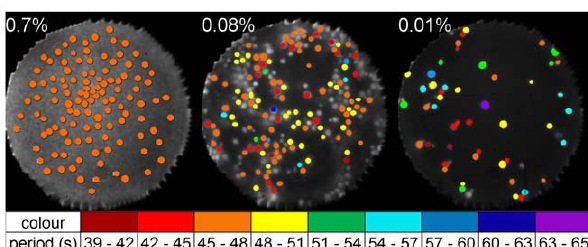
Figure 5. Mapping of the oscillation periods of individual cells in a population, for three experiments at cell densities of 0.7%, 0.08% and 0.01%, respectively. While for high cell densities (e.g. r =0.7%; not all cells labelled) all cells show same the oscillation period, the cells lose coherence in oscillation periods at lower cell densities ( r =0.08% and 0.01%). Regions, where all cells of the cluster oscillate with same period, are not found in populations of low densities ( r =0.08% and 0.01%). At densities below r =0.3%, domains devoid of cells are present in the areas of observation. Marked cells without colouration did not show distinctive oscillations. The field of view has a diameter of 169 m m.